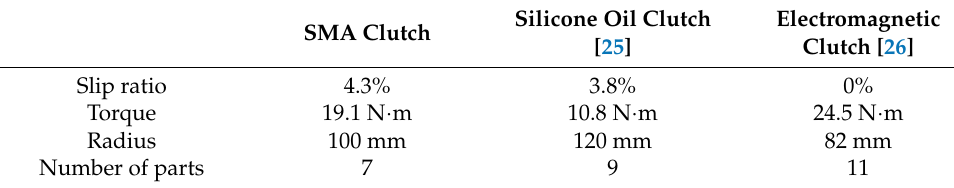
Table 2. Fan clutches performance